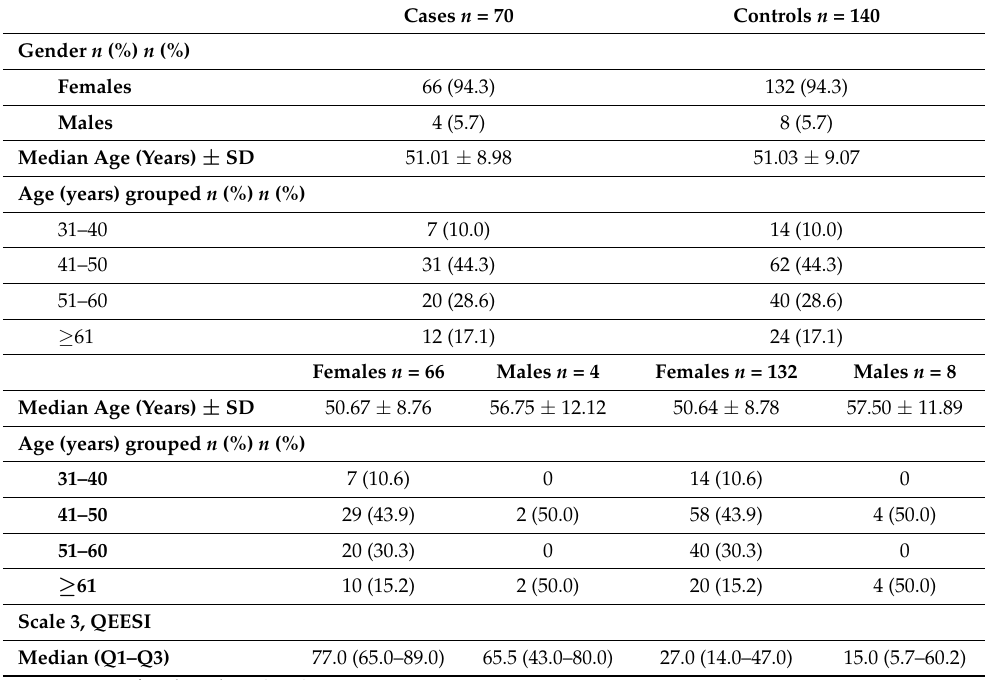
Table 4. Sociodemographic and clinical variables of cases and